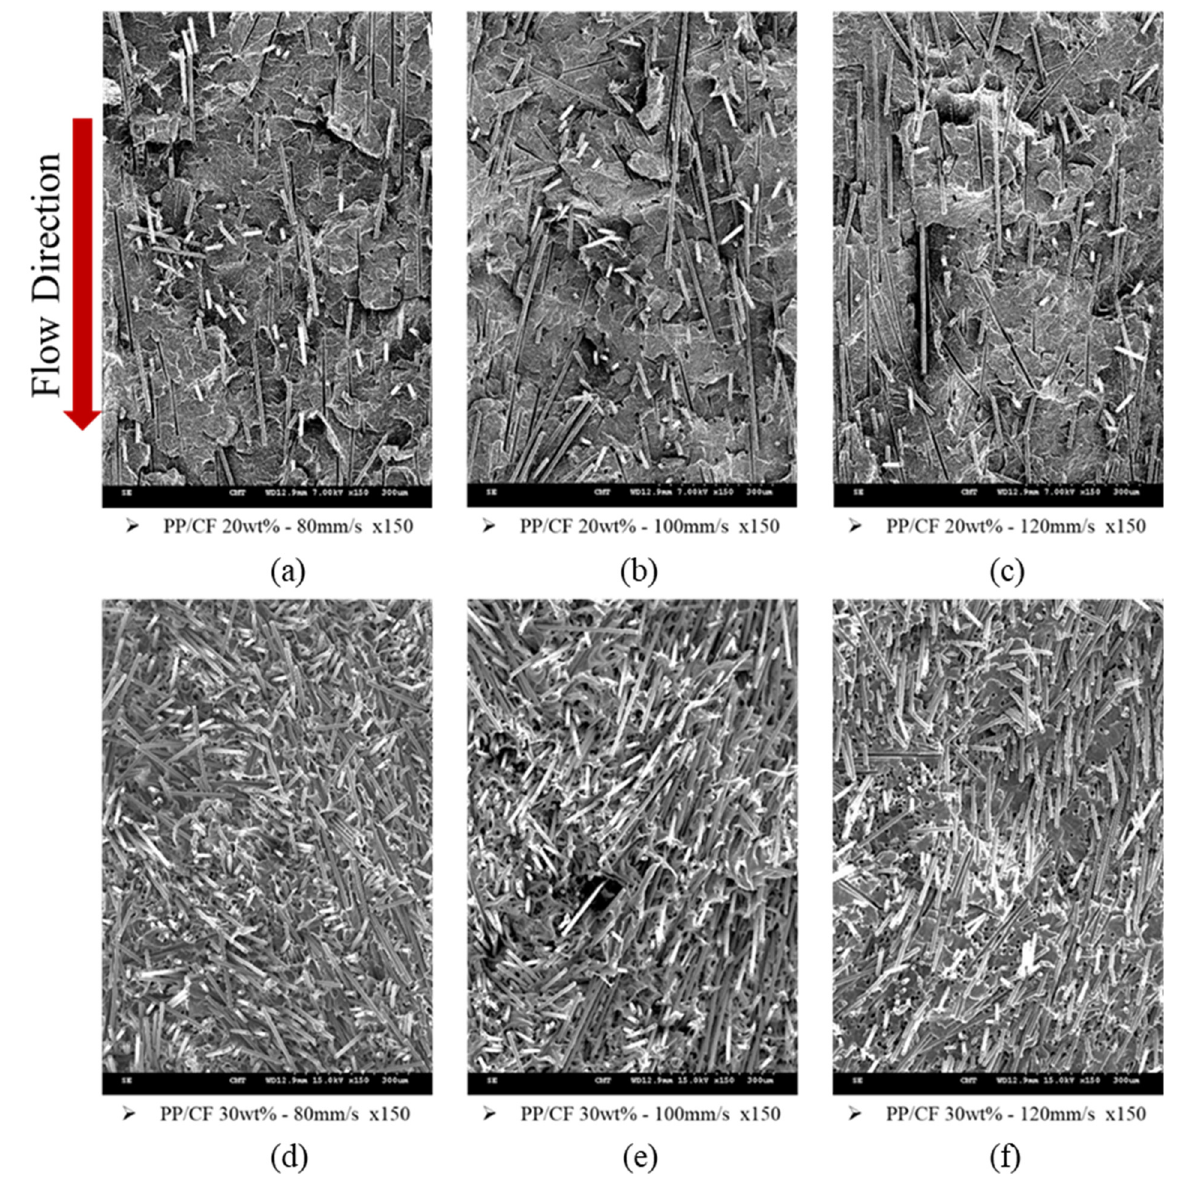
Figure 4. Fiber orientations under various injection speeds. ( a ) Polypropylene (PP)/carbon fiber (CF) 20 wt%, 80 mm/s. ( b ) PP/CF 20 wt%, 100 mm/s. ( c ) PP/CF 20 wt%, 120 mm/s. ( d ) PP/CF 30 wt%, 80 mm/s. ( e ) PP/CF 30 wt%, 100 mm/s. ( f ) PP/CF 30 wt%, 120 mm/s.